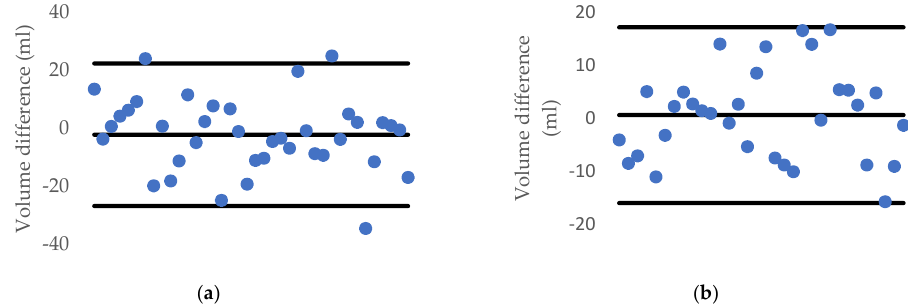
Figure 25. 1.96-σ plot for the volume difference between the water displacement and MLR method: Figure 25. 1.96- σ plot for the volume di ff erence between the water displacement and MLR method: ( a ) carrot and ( b ) cucumber. ( a ) carrot and ( b ) cucumber.